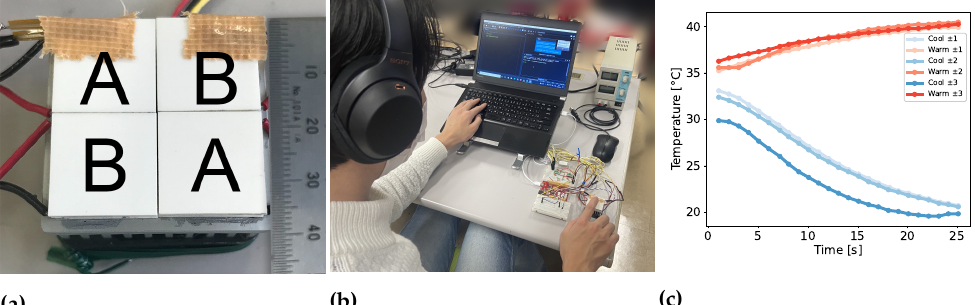
Figure 3. Experiment setup of pre-cooling/pre-warming effect. ( a ) 2 × 2 tiled Peltier devices. The total size of Peltier devices was 36 mm 2 ( b ) System overview of the experiment about pre-cooling/pre- warming effect ( c ) Examples of both A and B parts’ thermal histories. As an adaptation temperature, we set 33 °C. To adapt to the temperature, the participants kept their hands on the device for three minutes. As a cooling/warming temperature target, we set 20 and 40 °C for